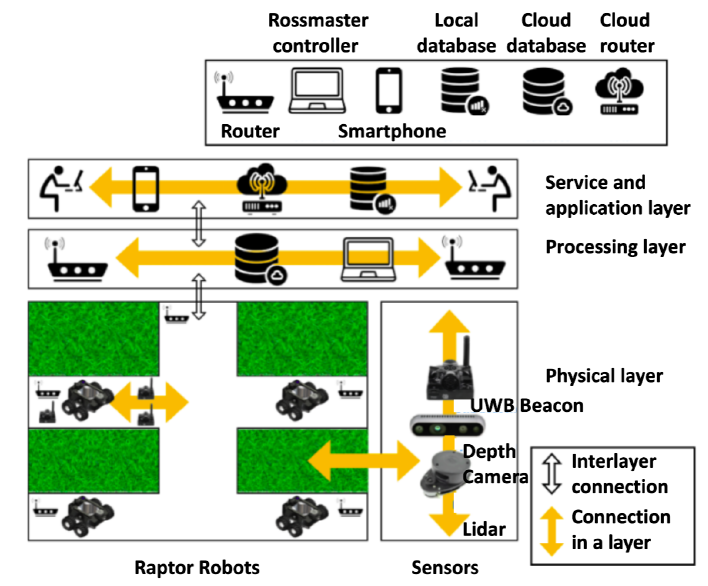
Figure 1. Overview of the drain inspection